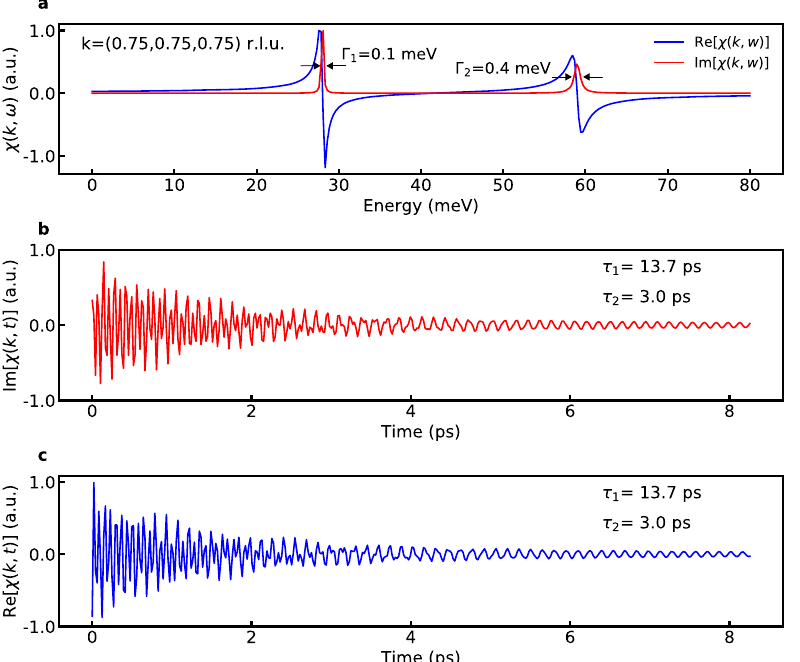
Fig. 2 Decay width and lifetime of phonon modes at particular k point. a Real and imaginary parts of χ ( k , ω ) at particular k = (0.75, 0.75, 0.75) r.l.u. The decay widths corresponding to two active modes are Γ 1 = 0.1 meV and Γ 2 = 0.4 meV. b Imaginary part of χ ( k , t ), which provides the lifetimes of the active phonon modes as τ 1 = 13.7 ps and τ 2 = 3.0 ps. c Real part of χ ( k , t ), which gives the same values of the lifetimes of the active phonon modes. All the quantities plotted in sub-plots are